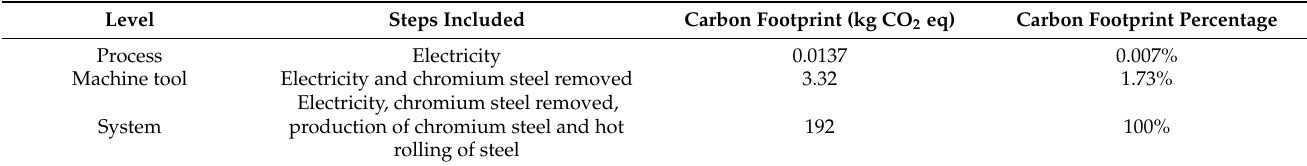
Figure 3. Allocation and percentages of carbon footprint per step in conventional milling, showing that the highest percentage of carbon footprint is coming from the production of steel (93%). Table 4. Carbon footprint for conventional milling per level.